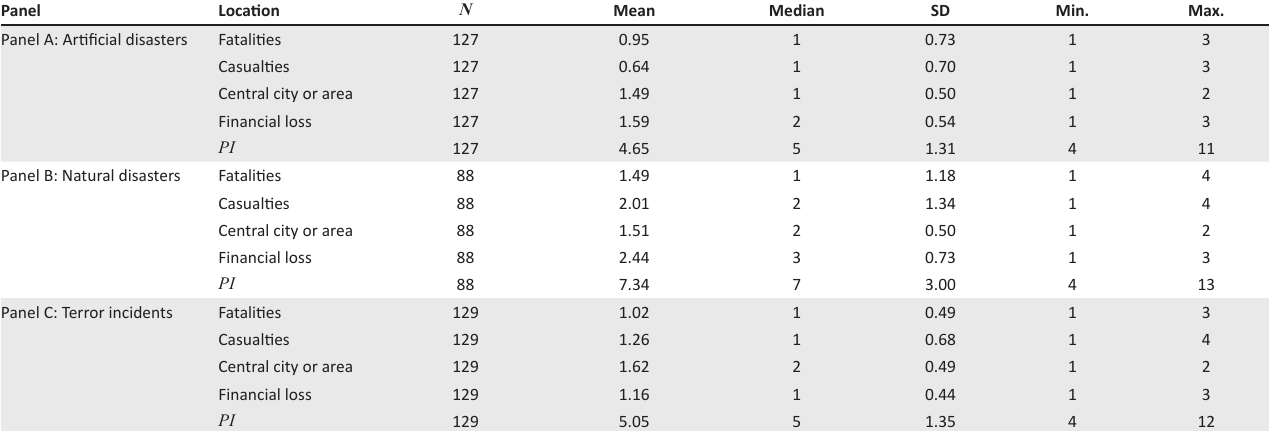
TABLE 1: Statistical data on event severity and type.